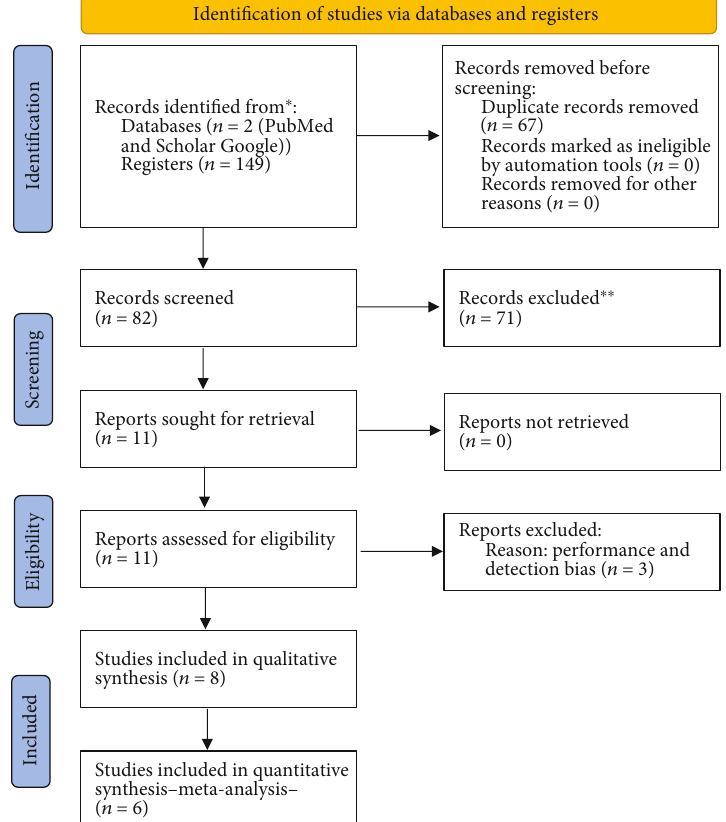
Figure 1: Study fl ow